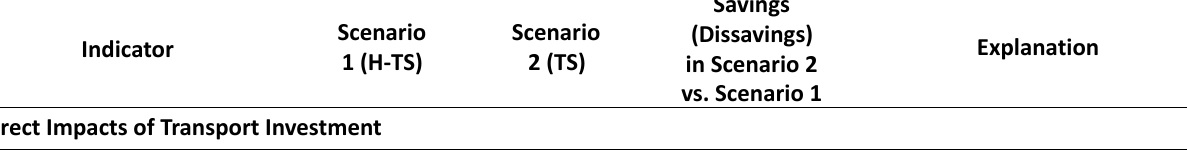
Table 6. Quantitative assessment of selected indicators for the dispersed and compact development scenarios in the Leipzig-Halle Region. Dissavings are shown in parentheses with a negative sign. By slow modes of transportation, we refer to walking and